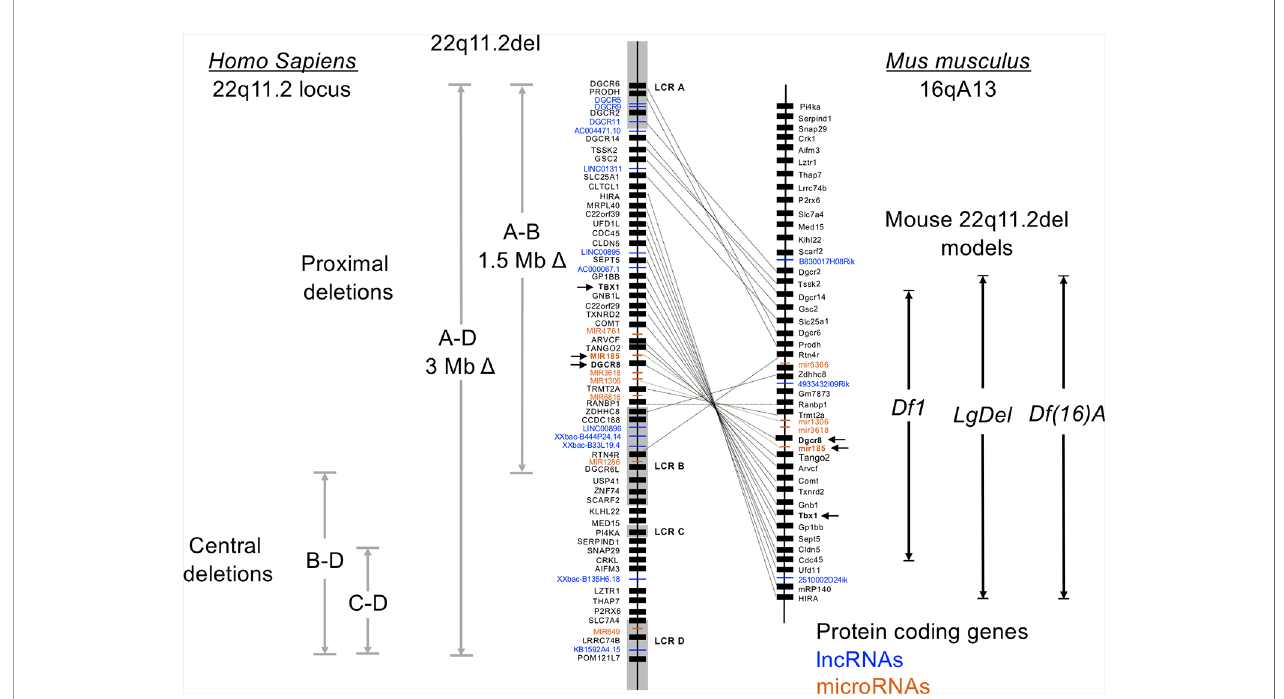
FIGURE 1 | Genetic organization of the human chromosome 22q11.2 locus and synteny on murine chromosome 16. Human chromosome 22 is approximately 51 million base pairs. The region affected by the 22q11.2 chromosomal deletions and duplications spans approximately 4 Mb, with 8 low copy repeats (LCR A-LCR H) causal to this distributed throughout this region. LCR A-LCR D are shown. Recombination of these highly homologous sequences (also called segmental duplications) results in proximal, central, and distal (not shown) deletions affecting both coding and noncoding DNA segments. The proximal deletions are responsible for the classic clinical features of 22q11.2del, which includes DiGeorge syndrome. The location of the coding genes, and noncoding RNAs including miRNAs and lncRNAs, are shown for the proximal region of chromosome 22q11.2. The corresponding genes on the murine locus are connected with lines, which reveals a fl ipping of the locus and a break containing distinct genes. Three of the more commonly used mouse models of 22q11.2del that replicate many clinical features of 22q11.2del are shown, named as the Df16(A), Df1 and Lgdel